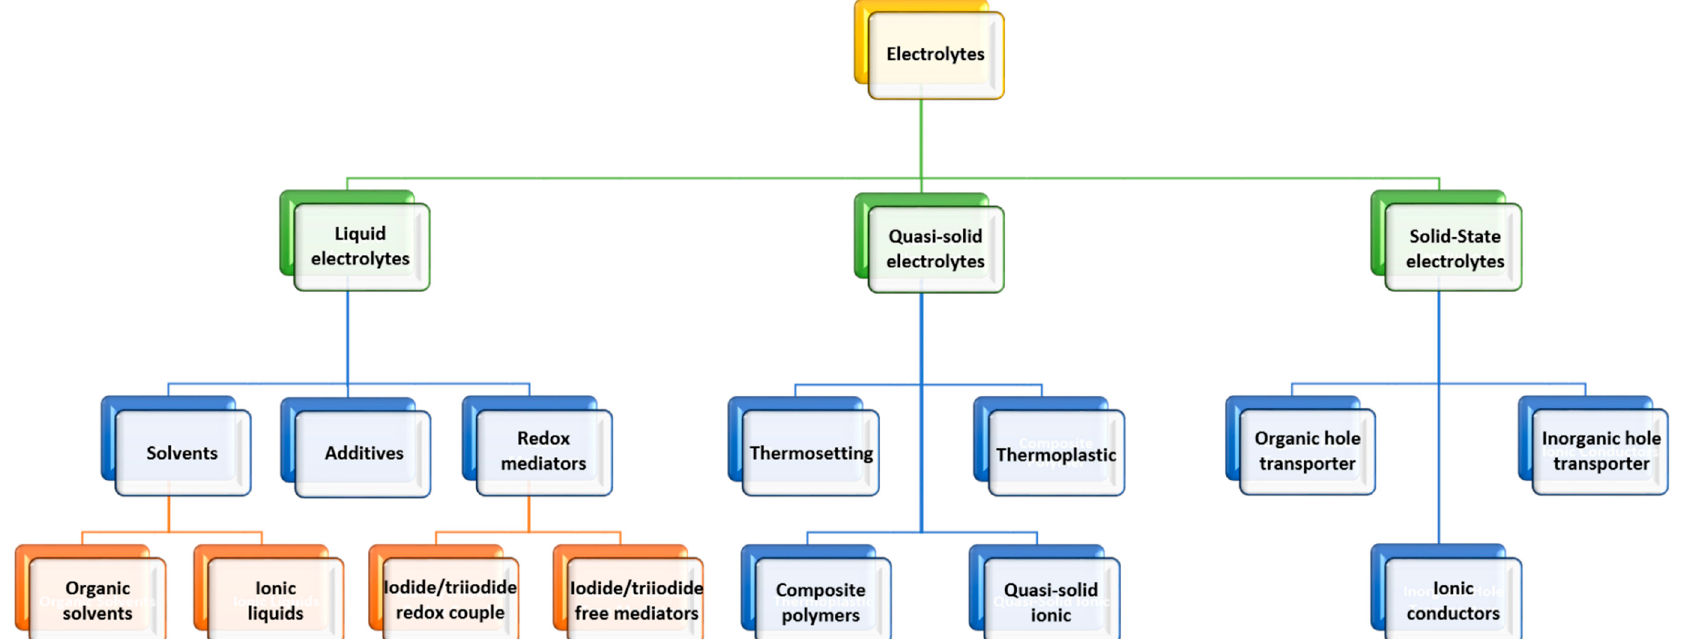
Figure 6. Classifications of electrolytes developed for DSSCs.